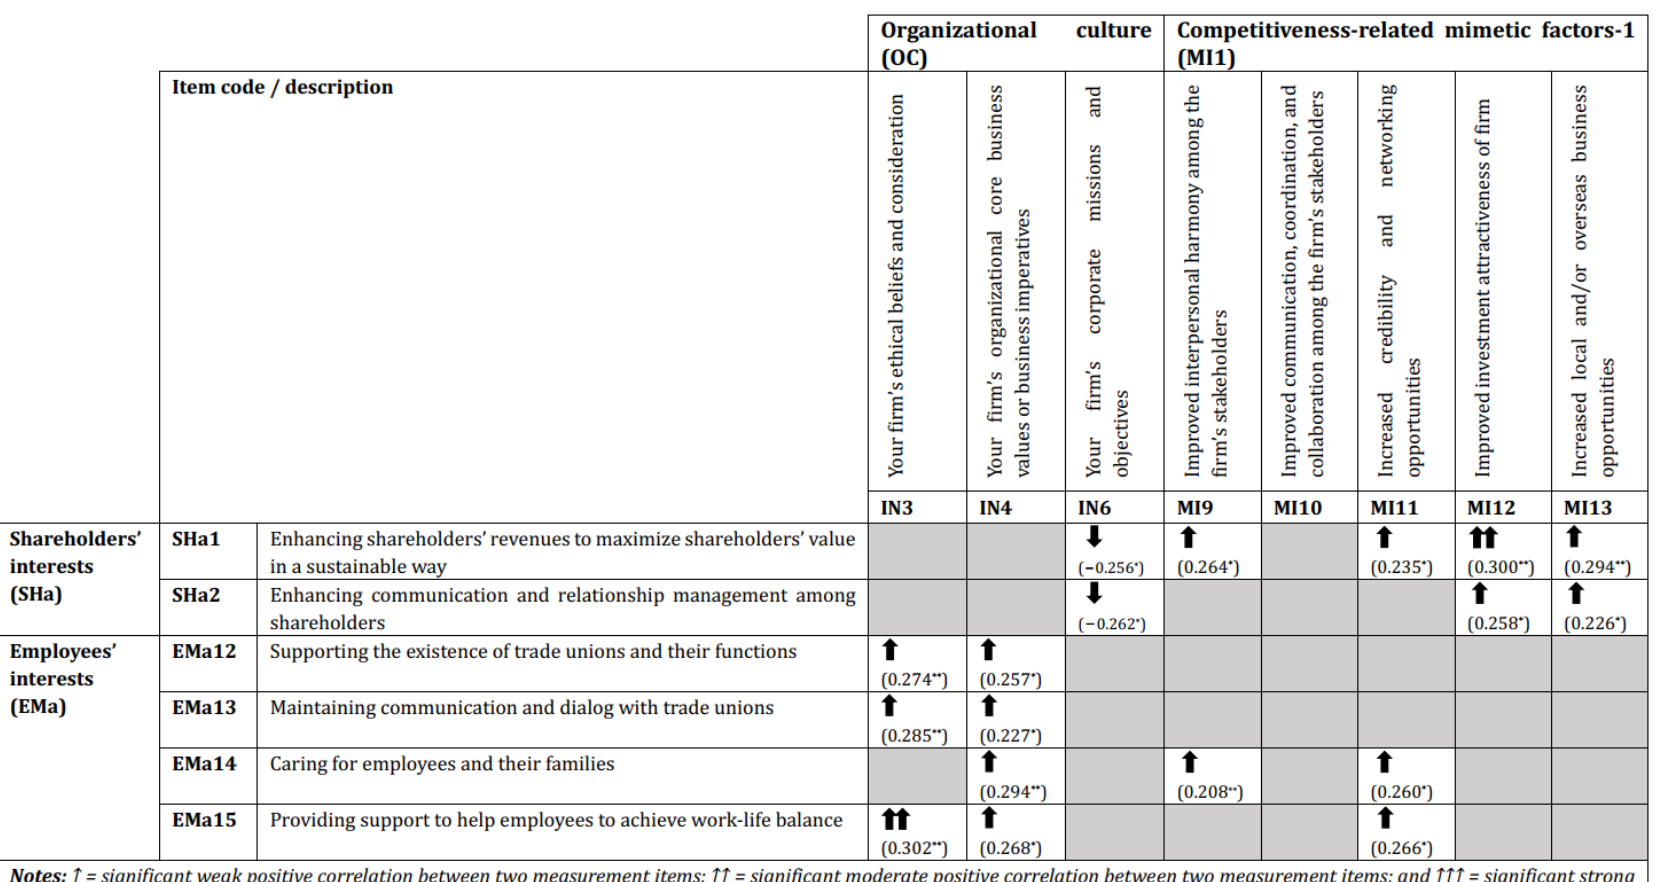
Figure 5. Relationship guide 2 for checklists of corporate social responsibility implementation.